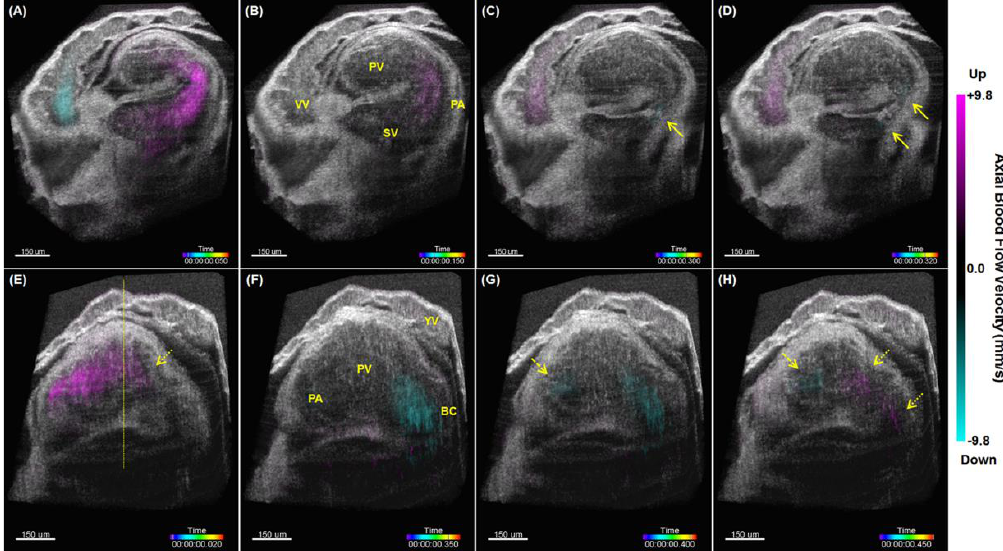
Figure 7. 4-D imaging of hemodynamics in the live E9.0 mouse embryonic heart. ( A – D ) are cross- sectional views that focus on the sinus venosus, primitive atrium and vitelline vein at different time points of cardiac cycle. ( E – H ) are cross-sectional views that focus on the primitive ventricle and bulbus cordis at different time points of cardiac cycle. Solid arrows point at retrograde flows in the primitive atrium. Dashed arrows point at retrograde flows in the atrioventricular region. Dotted arrows point at retrograde flows in the bulbus cordis and the bulboventricular region. YV: yolk sac vessel; VV: vitelline vein; SV: sinus venosus; PA: primitive atrium; PV: primitive ventricle; BC: bulbus cordis. Reproduced with permission from [71].